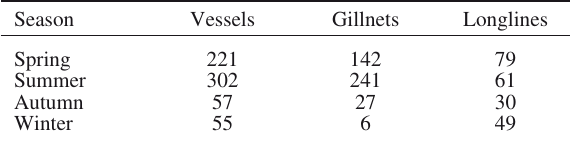
Table 2. – Number of fishing vessels sampled by season and gear type.